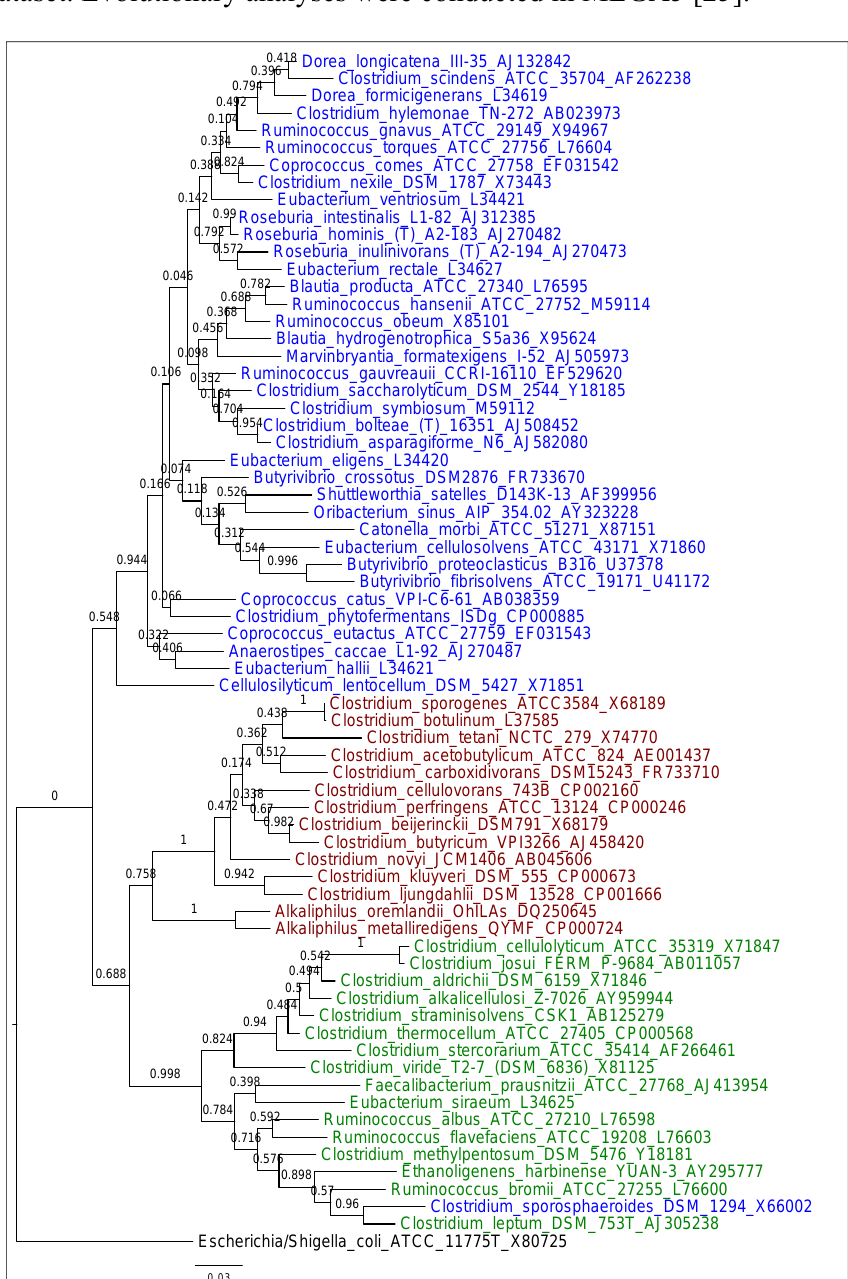
Figure 1. Molecular Phylogenetic analysis by Maximum Likelihood method: Phylogeny was inferred using the Maximum Likelihood method based on the Tamura-Nei model [24]. The tree with the highest log likelihood ( − 16219.1561) is shown. The percentage of trees in which the associated taxa clustered together (of 500 bootstrap replicates) is shown next to the branches. Initial tree(s) for the heuristic search were obtained automatically by applying Neighbor-Join and BioNJ algorithms to a matrix of pairwise distances estimated using the Maximum Composite Likelihood (MCL) approach, and then selecting the topology with superior log likelihood value. The tree is drawn to scale, with branch lengths measured in the number of substitutions per site. The analysis involved 69 nucleotide sequences. Codon positions included were 1st + 2nd + 3rd + Noncoding. All positions containing gaps and missing data were eliminated. There were a total of 984 positions in the final dataset. Evolutionary analyses were conducted in MEGA5